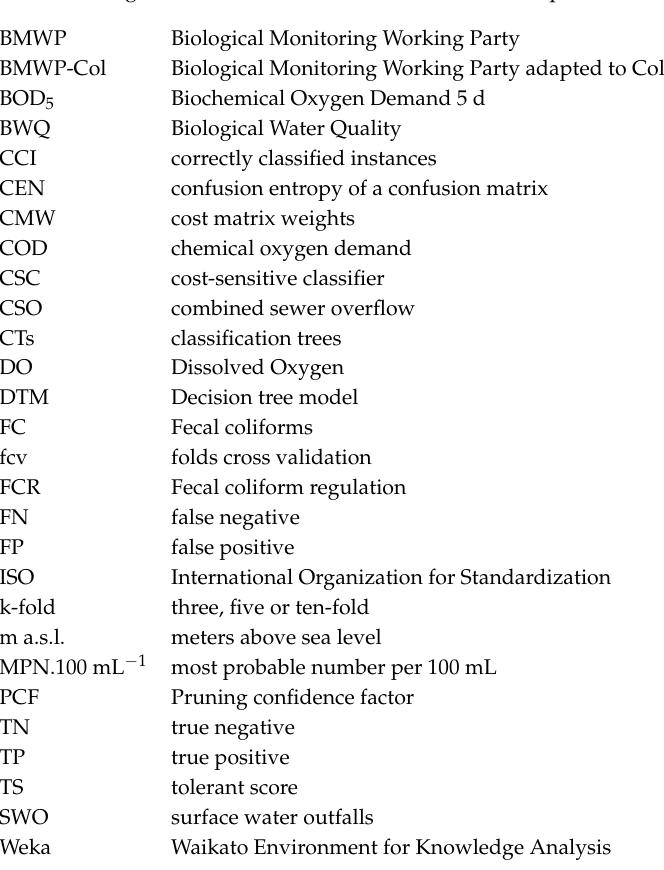
Figure S1: Sampled sites location 2012, 2015 and 2016; Table S1: Verification of the fulfilment of the recreational with primary contact Ecuadorian water use regulations associated with fecal coliforms according the decision tree models (DTMs); Table S2: Verification of the fulfilment of the agriculture and livestock water use regulations associated with fecal coliforms according the decision tree models (DTMs), before the optimization process; Table S3: Verification of the fulfilment of the recreational with primary contact Ecuadorian water use regulations associated with fecal coliforms according the decision tree models (DTMs), with new dataset taken in July of 2015 (dry season) and March of 2016 (rainy season); Table S4: Verification of the fulfilment of the agriculture and livestock Ecuadorian water use regulations associated with fecal coliforms according the decision tree models (DTMs), with new dataset taken in July of 2015 and March of 2016; Table S5: Calculation of the variation of correctly classified instances (CCI) and Kappa statistics in the recreational fecal regulation models, in which three cross validations were manually applied; Table S6: Calculation of the variation of correctly classified instances (CCI) and Kappa statistics in the agriculture fecal regulation models, in which three cross validations were manually